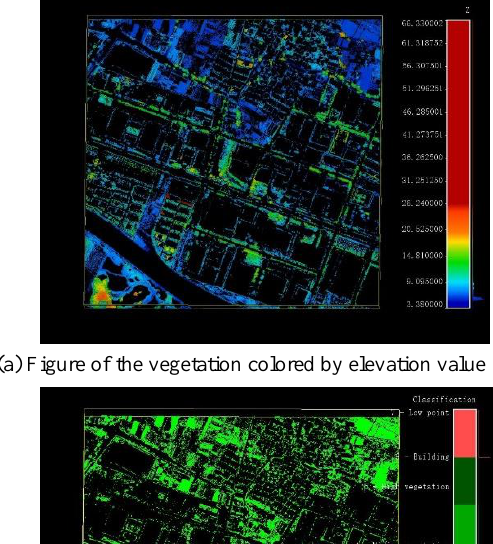
(c) Figure of omission of the woodland Figure 6. Results of the vegetables quality